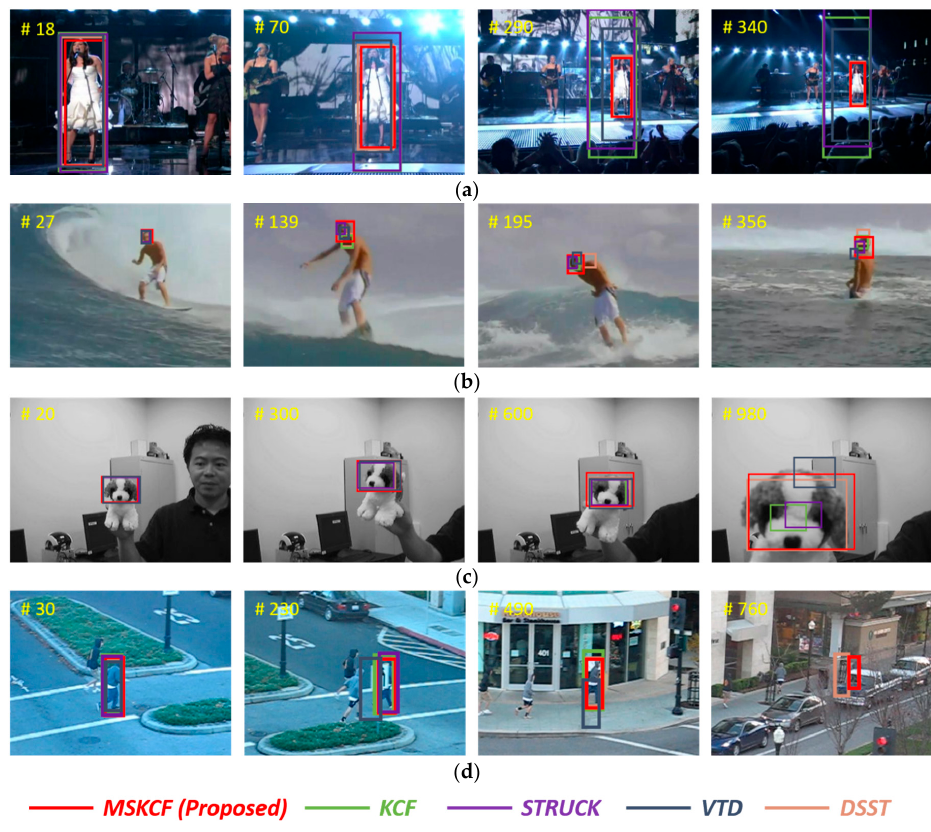
Figure 7. Tracking results under scale variations. ( a ) Singer1; ( b ) Surfer; ( c ) Dog1; and ( d )